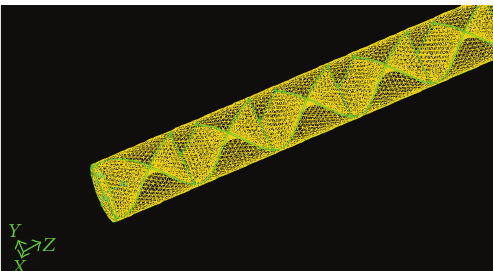
Table 2: Numerical values of the parameters used for